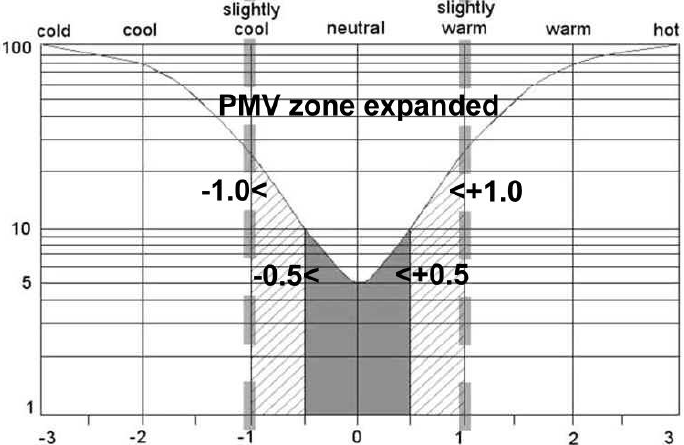
Figure 4. Predicted Percentage Dissatisfied (PPD) compared to Predicted Mean Vote (PMV) showing the impact of extending the comfort standard range (adapted from